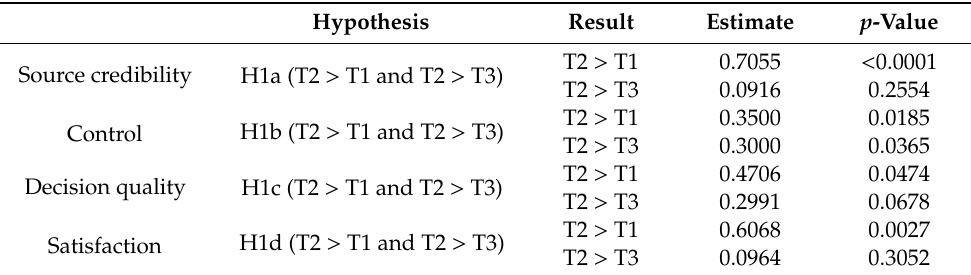
Table 1. Participants’ perception results.